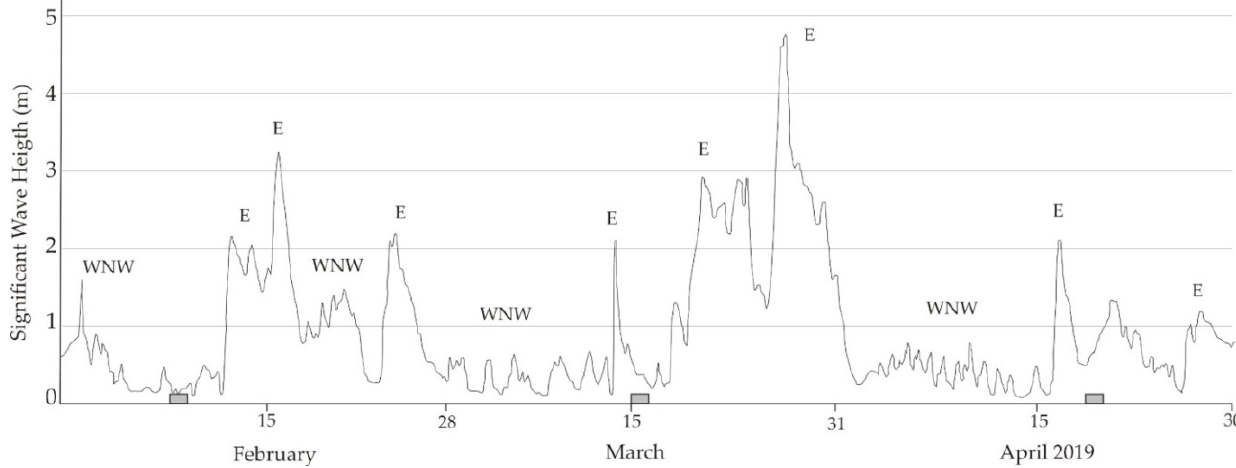
Figure 3. Significant wave height and approaching direction during the investigated period. Grey rectangles represent beach litter